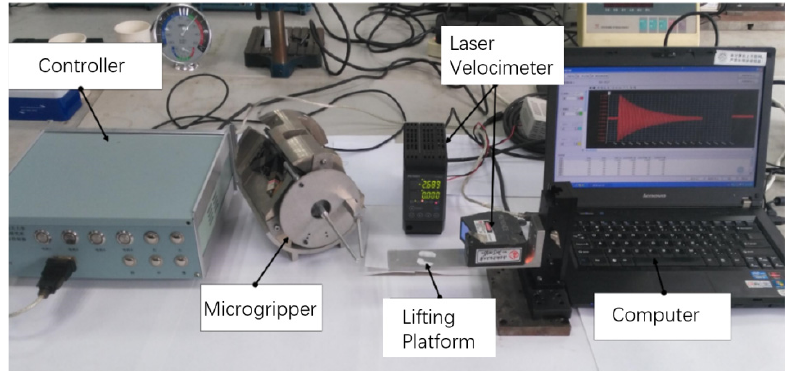
Figure 8. Vibration response test system.